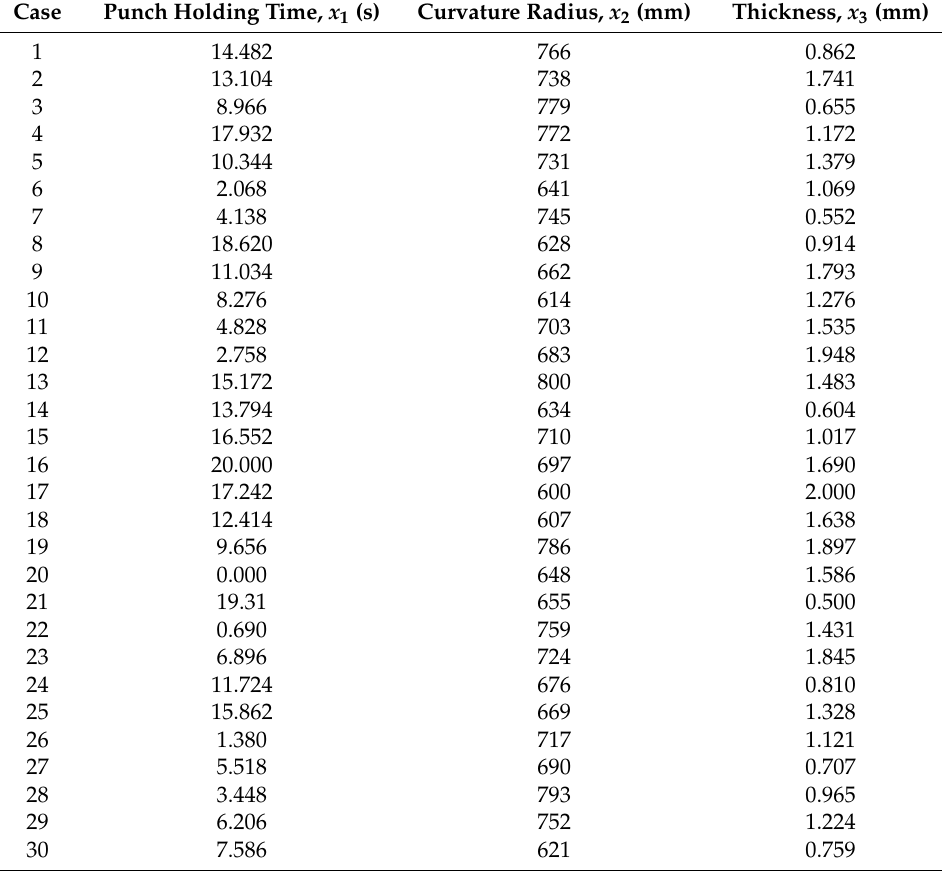
Table A1. Training sample